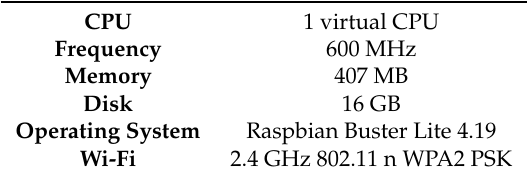
Table 2. Raspberry